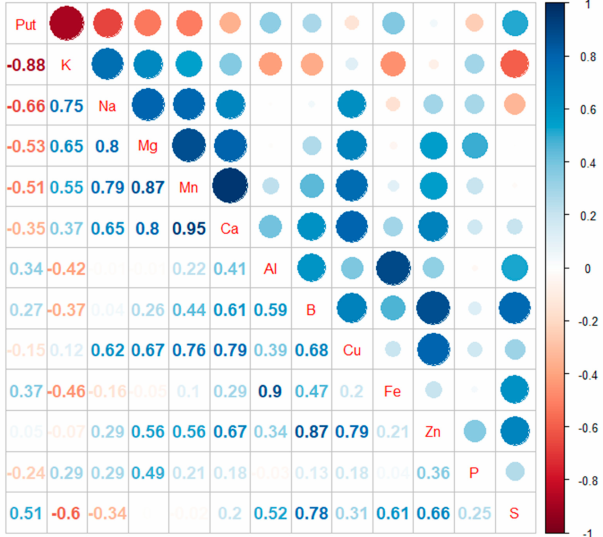
Figure 3. Correlation plot of the contents of free Put and chemical elements in Scots pine embryogenic cells under potassium treatments. Put correlated negatively with potassium (K, R 2 = − 0.88) sodium (Na, R 2 = − 0.66) magnesium (Mg, R 2 = − 0.53) and manganese (Mn, R 2 = − 0.51) and positively with sulfur (S, R 2 = 0.51). Put did not show a correlation between phosphorus (P), calcium (Ca), copper (Cu), zinc (Zn), boron (B), aluminum (Al), and iron (Fe) (0.37 > R 2 > −